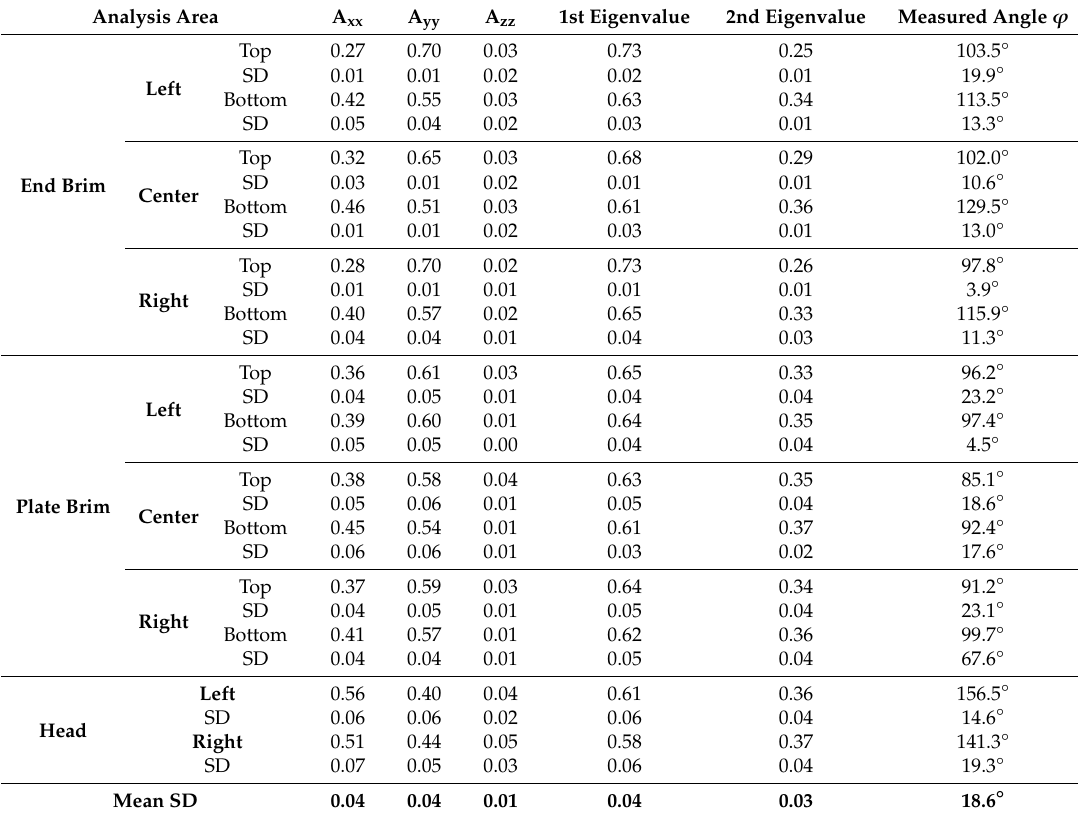
Table 7. Averaged fiber orientation measurement results for the brim and head analysis areas of three CT scanned ribbed hat